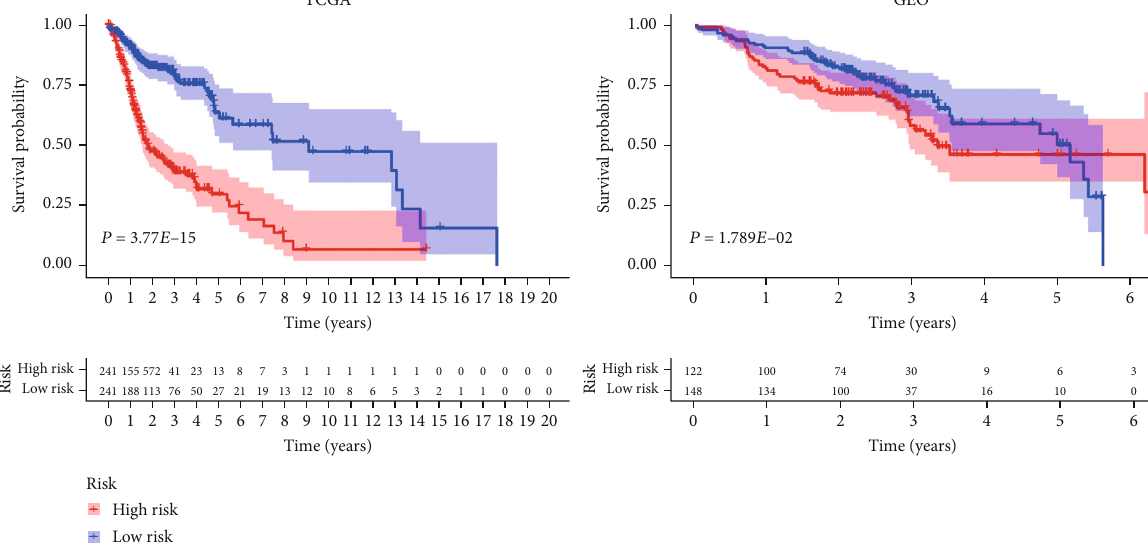
Figure 1: Overall survival (OS) analysis demonstrated that HNSCC with high-risk group had a more terrible prognosis than that with low- risk group ( P < 0 : 01